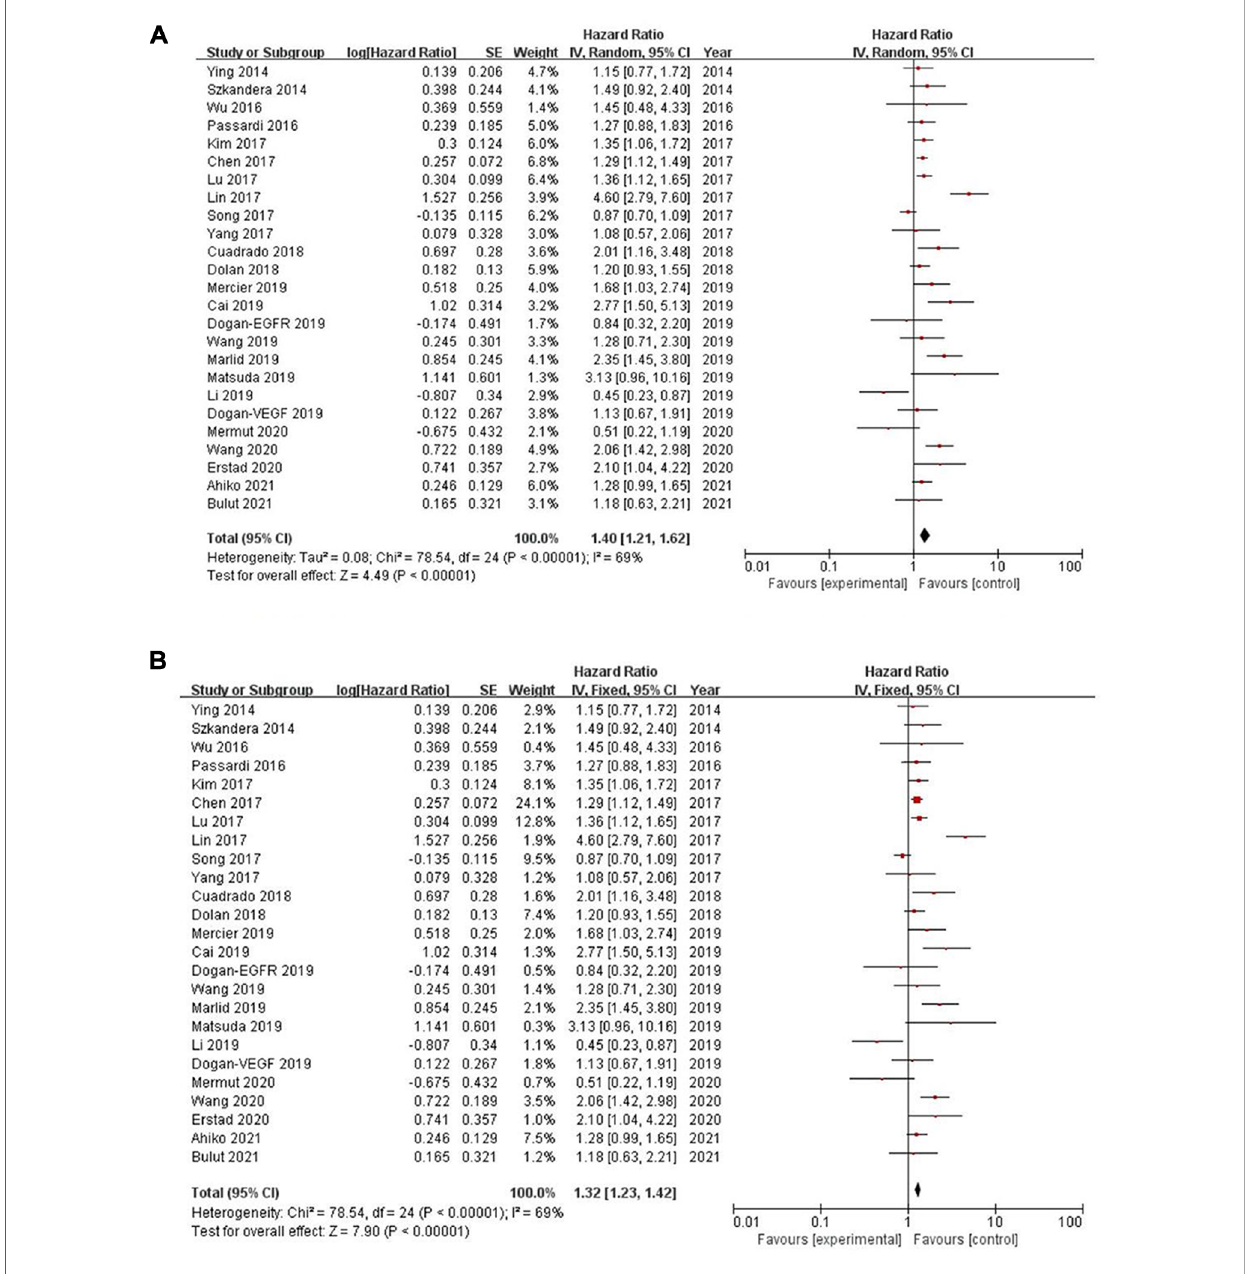
FIGURE 2 Forest graph on association of overall survival with different levels of platelet-to-lymphocyte ratio groups. ( A ) random effect model. ( B ) fi xed effect